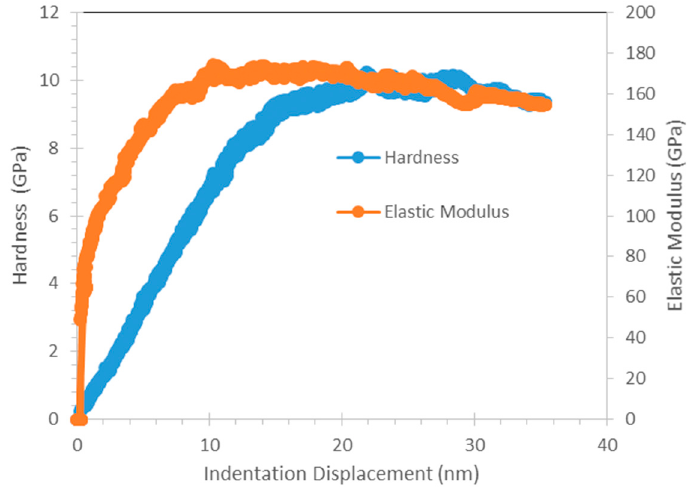
Figure 14. Hardness and Elastic Modulus of Cu 3 Al 2 plotted against indent displacement.